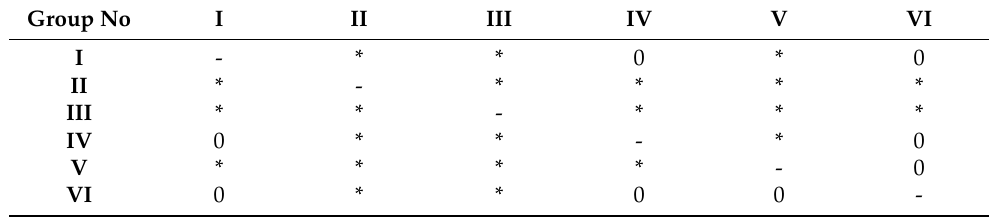
Table A8. The ratio of the capsule surface to the capillary tuft surface in rats fed with regular diet. Statistical differences between all experimental groups; * significant, 0